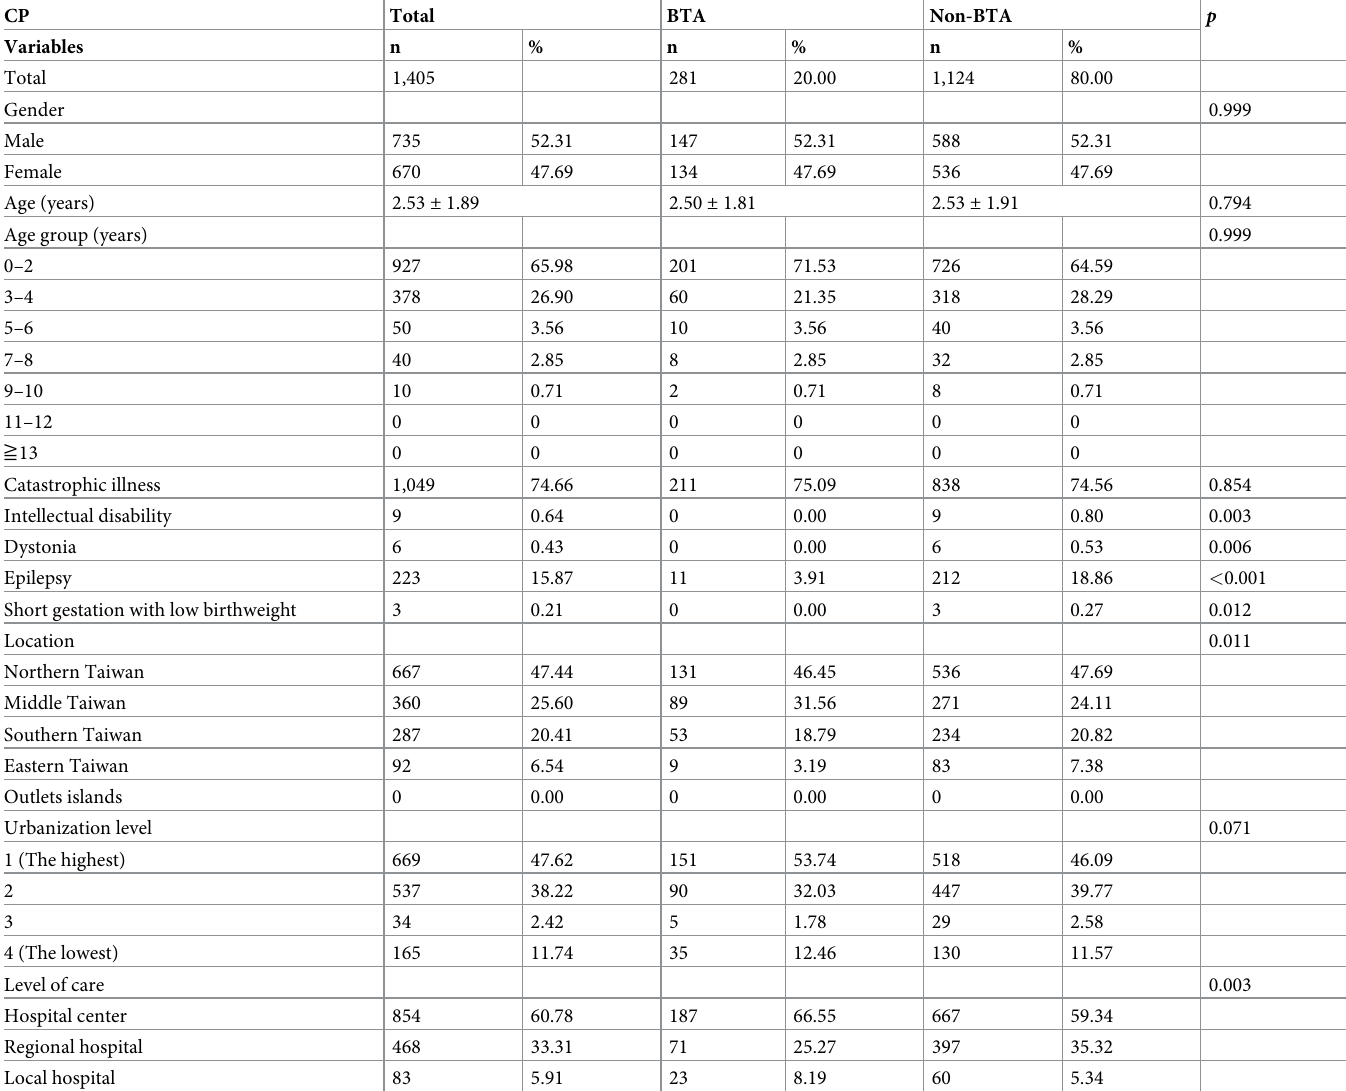
Table 1. Characteristics of the study population at